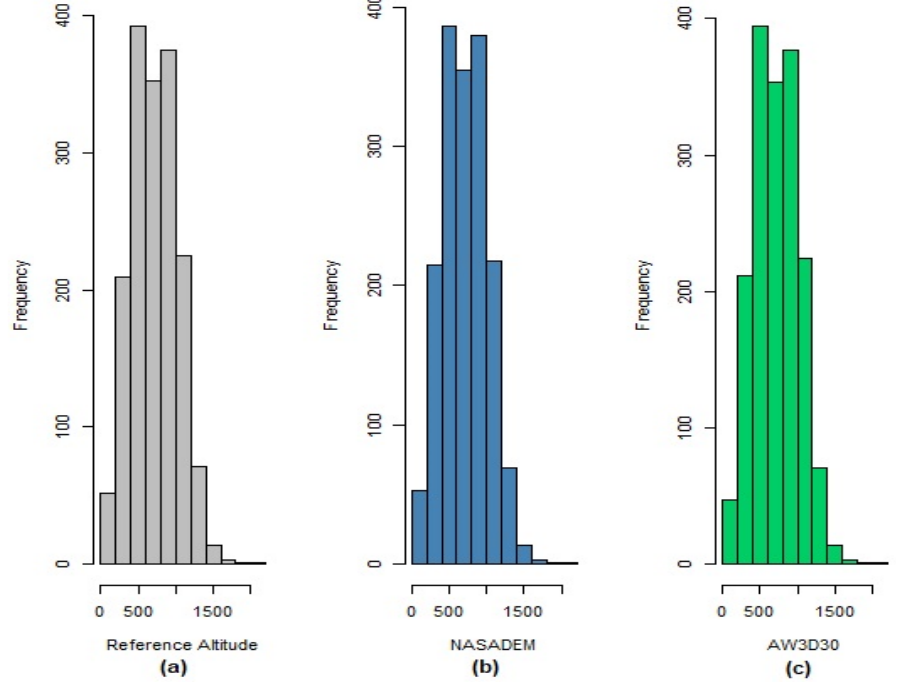
Figure 6. Histograms of altitudes from reference ( a ), from NASADEM_HGT ( b ), and AW3D30 ( c ) digital elevation models.